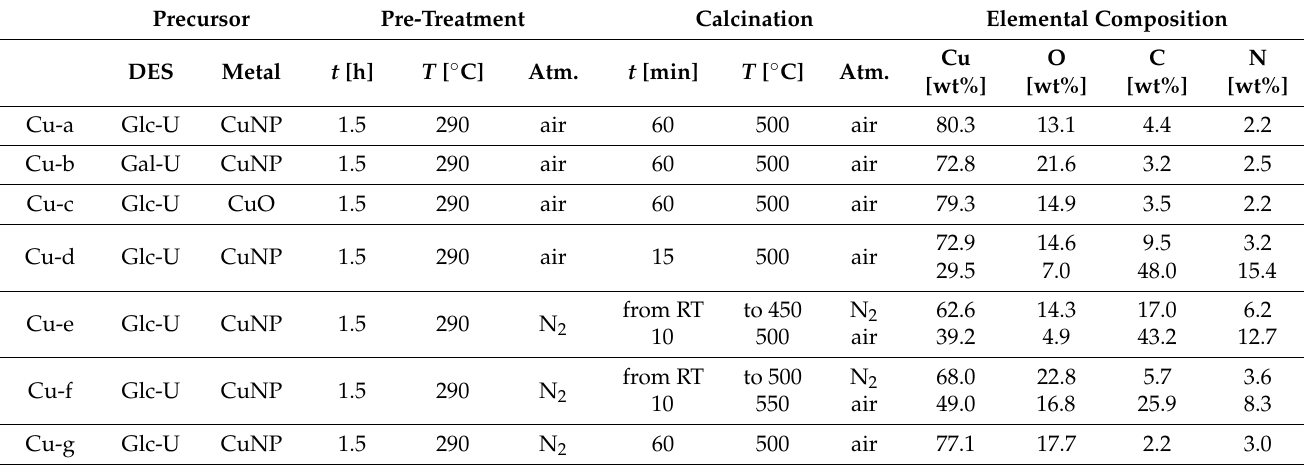
Table 6. Overview of the different preparation parameter. The following abbreviations correspond to Glc-glucose, Gal- galactose, U-urea, CuNP-copper nanopowder, and RT-room temperature. Cu-e and Cu-f were prepared in two steps: pyrolysis under inert atmosphere and oxidative treatment for 10 min. The measured elemental composition of the catalysts is shown after calcination. Cu-d, Cu-e, and Cu-f show two different types of particles: Cu-rich and Cu-poor ones. The CuO-60 catalysts are Cu-a, Cu-b, Cu-c, and